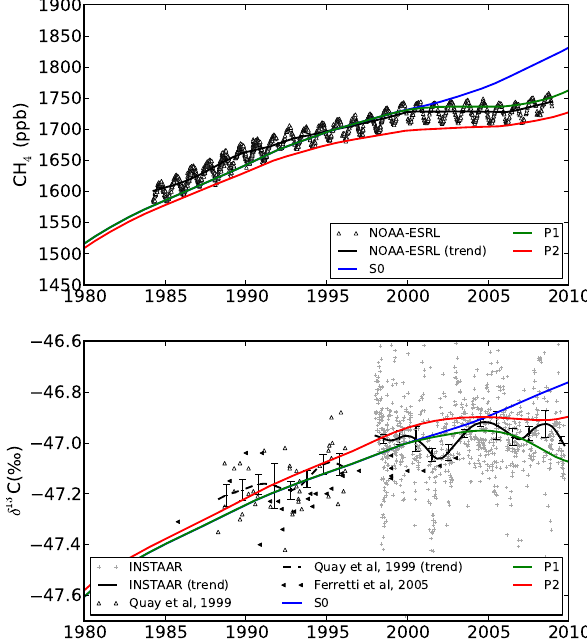
Fig. 4. Comparison of simulated and measured CH 4 and δ 13 C-CH 4 for the initial scenario S0 and the two proposed scenarios P1 and P2, at the station of Cape-Grim,